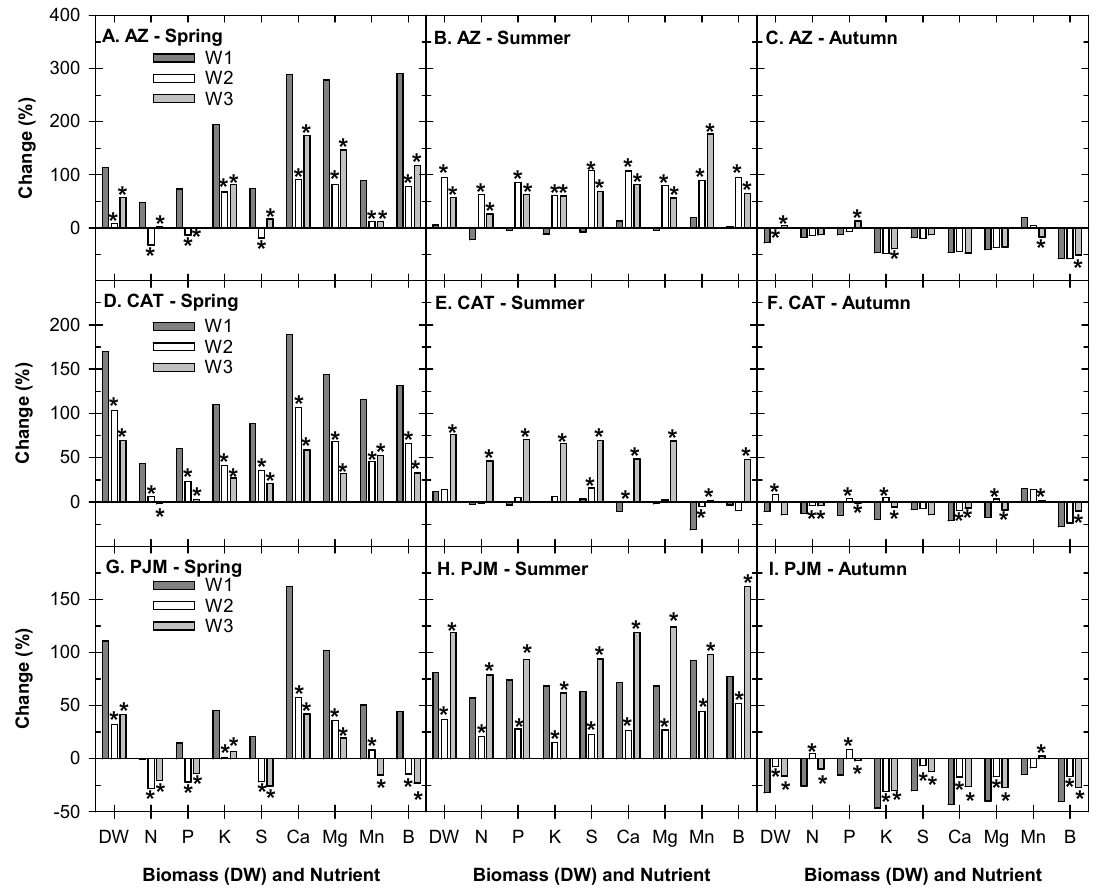
Figure 3. Change in biomass (dry weight; DW) and nutrient content of ‘Gibraltar’ (AZ) ( A – C ), ‘Catawbiense Album’ (CAT) ( D – F ), and ‘P.J.M.’ (PJM) ( G – I ) Rhododendron in the spring, summer, and autumn after transplanting them to soil in Year 2. The previous year, plants from each cultivar were grown in soilless media with N-free fertilizer (0 N) or N-free fertilizer plus 7 (0.5 N) or 14 (1.0 N) mg N per day from NH 4 NO 3 and irrigated once daily to 100% (W1) or 50% (W2) container capacity or twice daily to 100% container capacity (W3). Data are pooled across N treatments, and asterisks indicate the change in biomass or nutrient content was significantly increased or decreased by the W2 or W3 irrigation treatment when compared to the W1 treatment ( p ≤